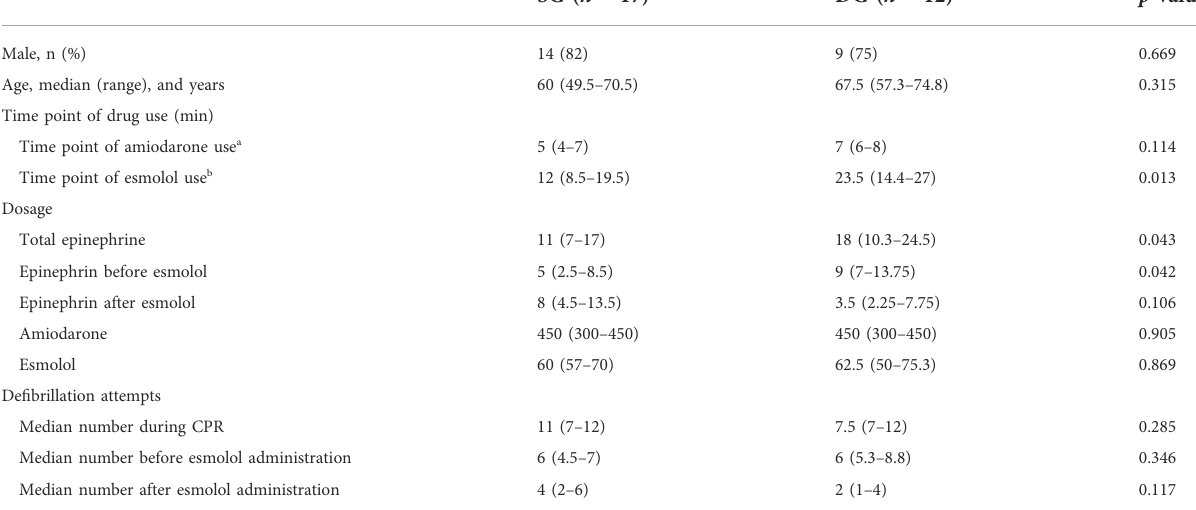
TABLE 2 Comparison of baseline characteristics and interventions between SG and